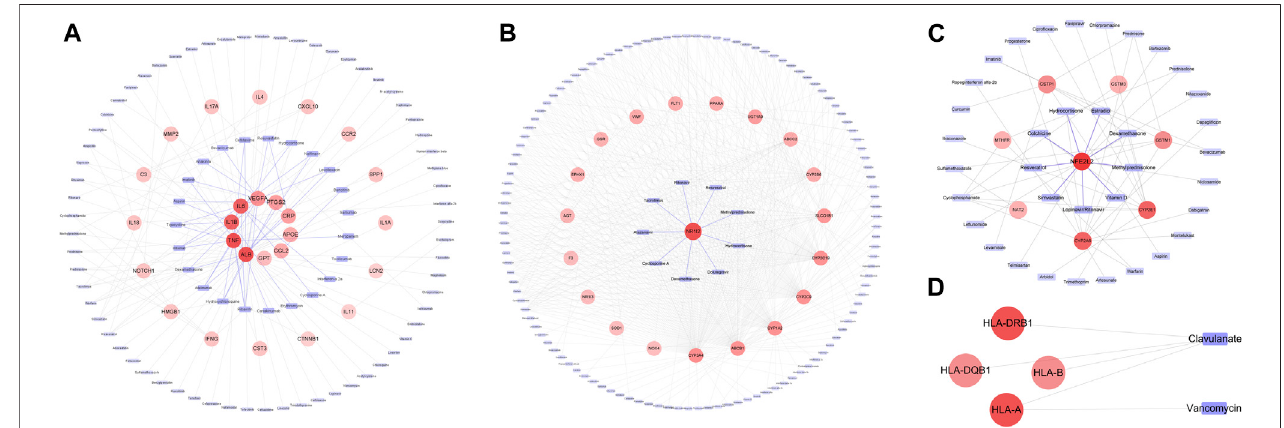
FIGURE 5 | Association between Drugs in DPTS and DILI targets in MCODE sub-networks: Cluster 1 (A) , cluster 2 (B) , cluster 3 (C) , and cluster 4 (D) .